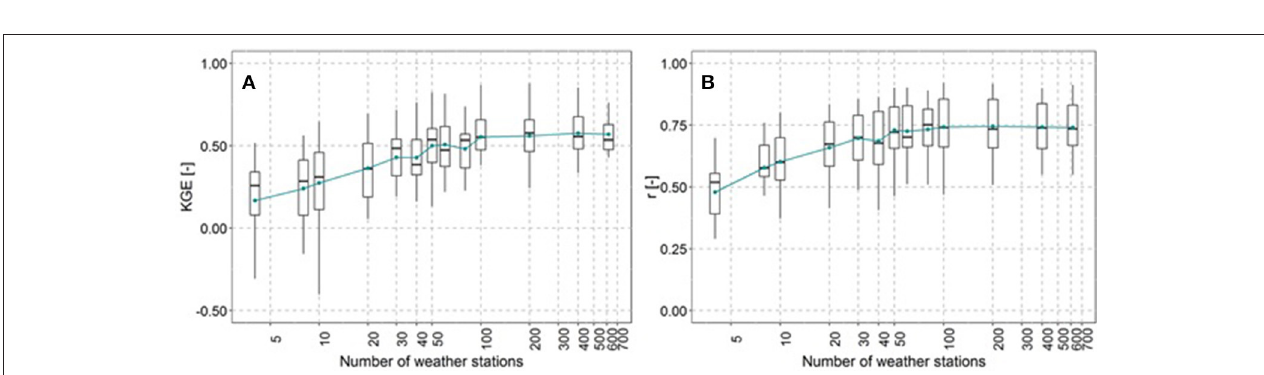
FIGURE 11 | r values (y-axis) between daily simulated and observed discharge when the model was forced with (A) CMORPH, (B) MSWEP, (C) PERSIANN, and (D) TRMM precipitation datasets at 1km resolution for the 2000–2012 period, derived with different number of weather stations (x-axis; 0, 4, 8, 10, 20, 30, 40, 50, 60, 80, 100, 200, 400, and 616). Logarithmic scale was used for the horizontal axis.